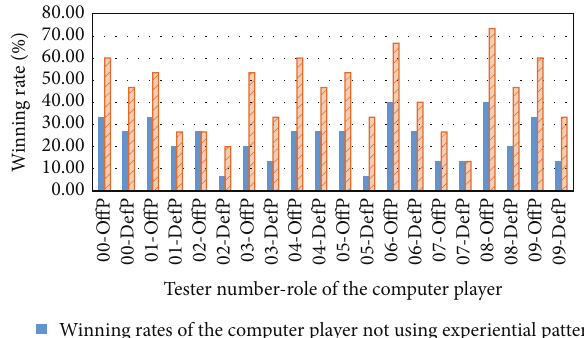
Table 7: Data records of the test in computer-computer mode. The computer player using experience patterns is denoted by CP1 and the other by